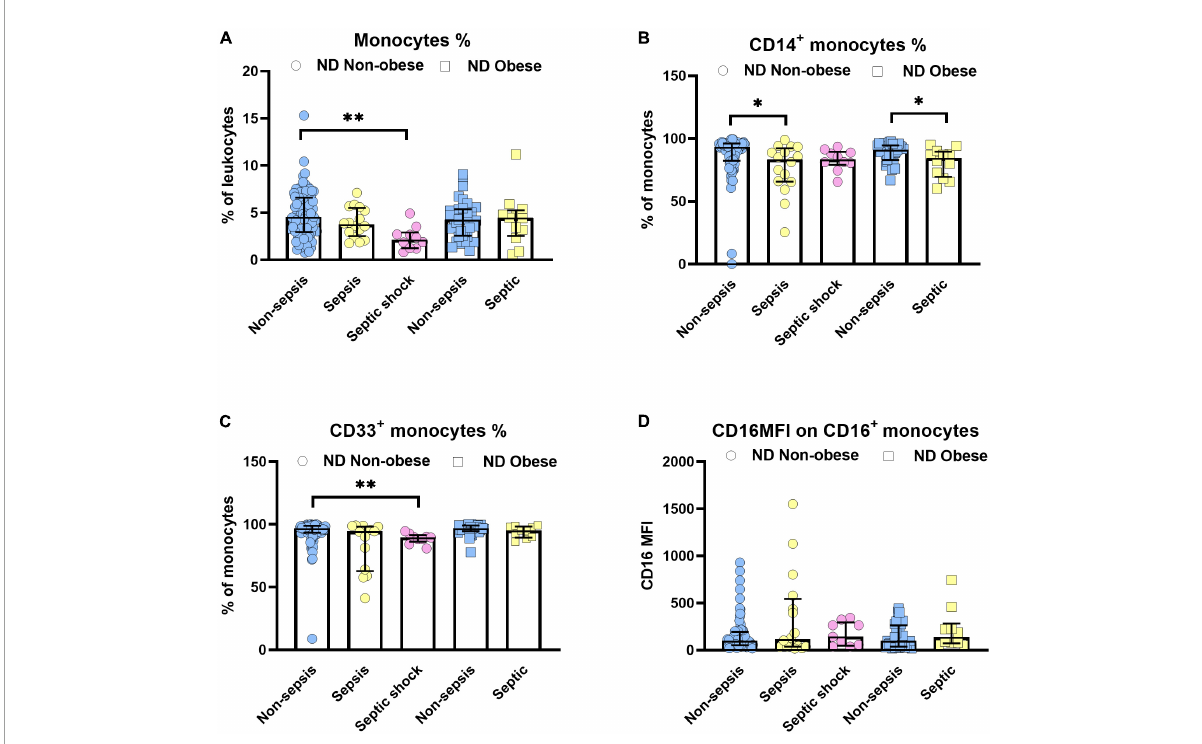
FIGURE2 Influence of obesity on monocytes in non-diabetic (ND) patients with or without sepsis status. Distribution changes in the percentage of monocytes among the total leukocyte population (A) and the percentage of CD14 + monocytes (B) and CD33 + monocytes among the monocyte population (C) . (D) Surface phenotype expression of CD16 on positive monocytes determined by mean fluorescence intensity (MFI). Data are presented by scatter with bar plots. Due to the small sample size, the obese group was not divided into sepsis ( n = 11) and septic shock ( n = 1) subgroups, rather presented as a combined “septic” group. Results are medians with interquartile range. Kruskal–Wallis test and Mann–Whitney U -test were, respectively, used to analyze the differences among three groups and two groups. Significant difference is marked by ∗ p < 0.05 and ∗∗ p <